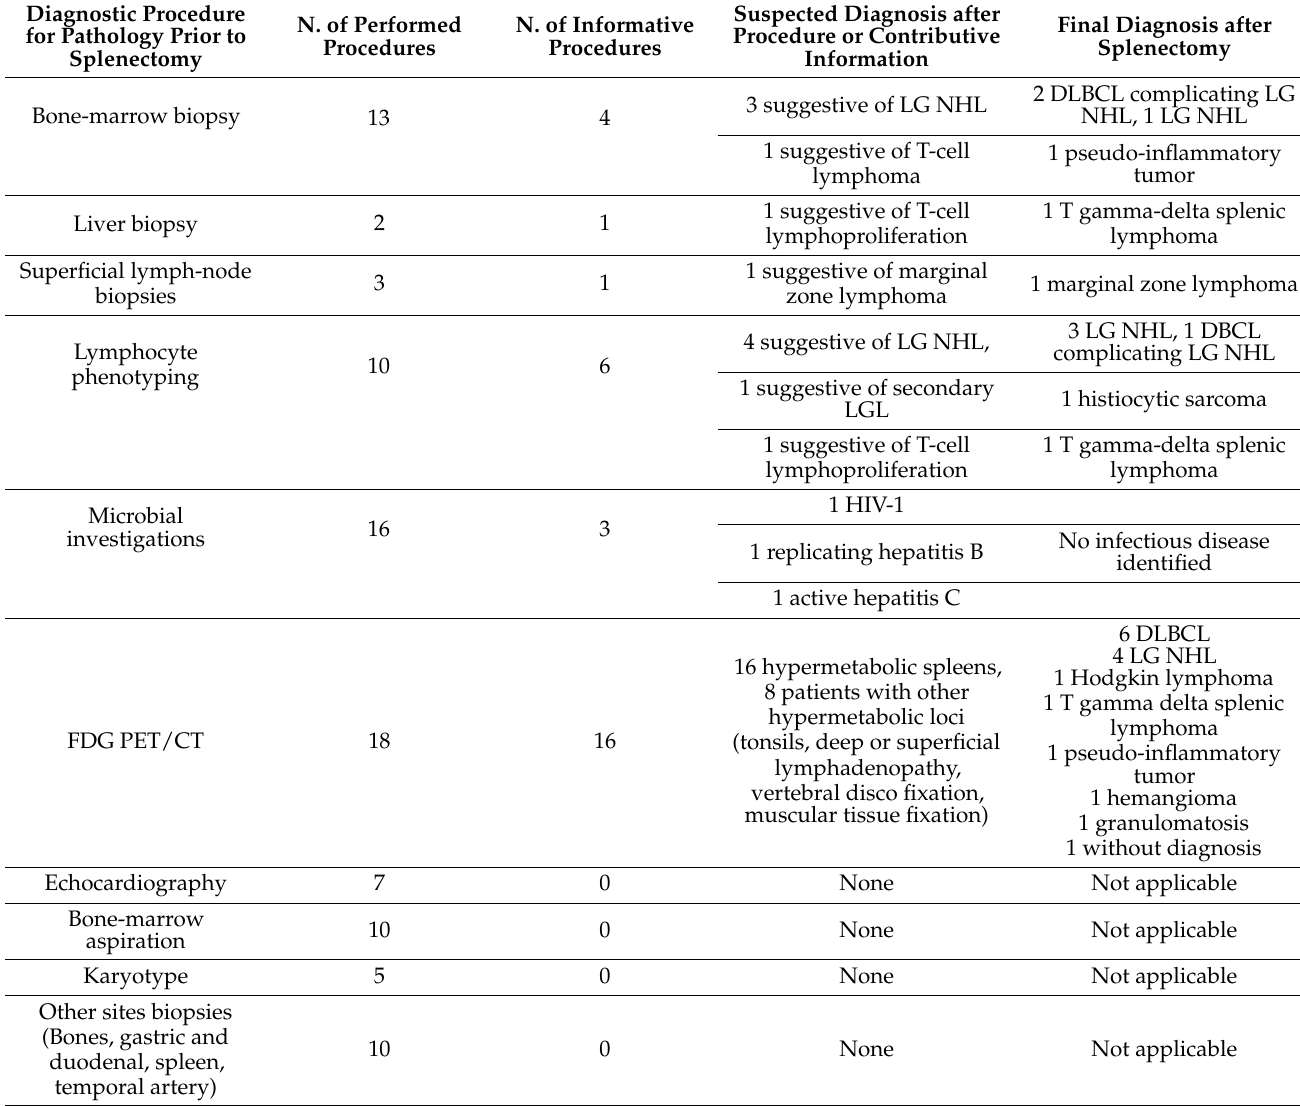
Table 2. Diagnostic investigations prior to the splenectomy and their results concerning the 20 patients. Diagnostic Procedure N. of Performed for Pathology Prior to Splenectomy